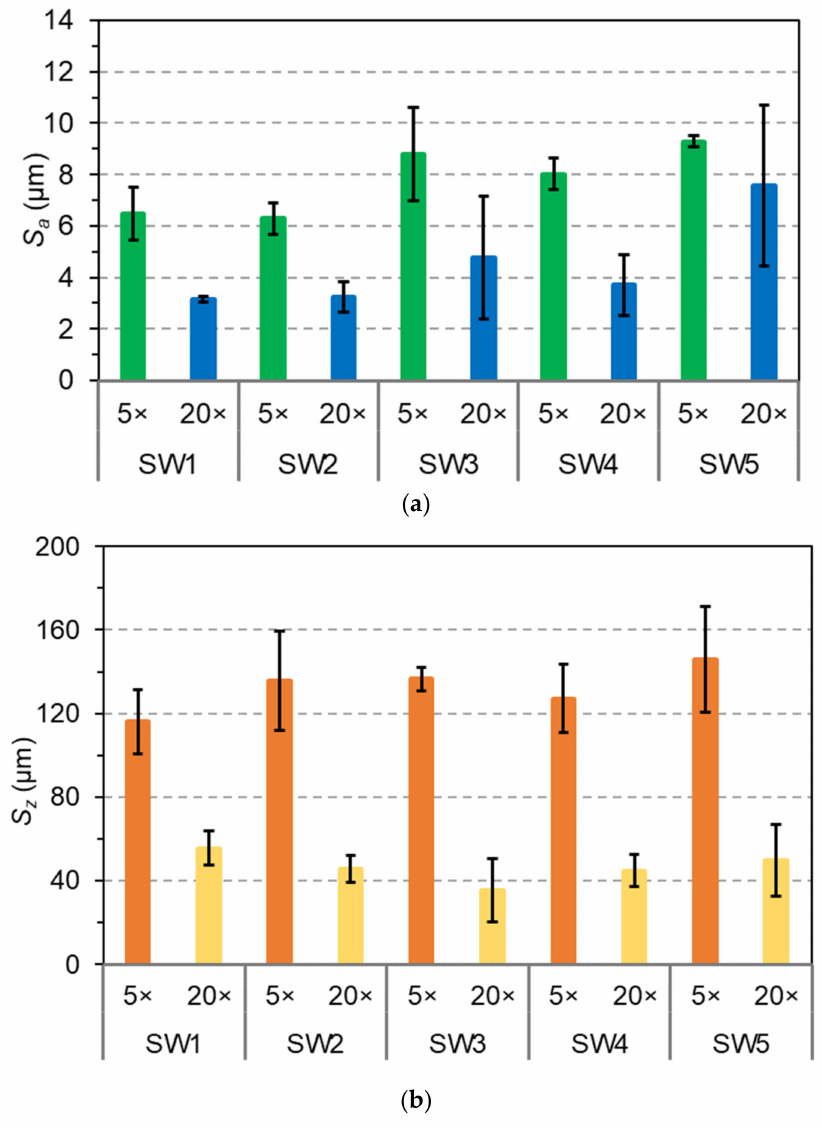
Figure 6. Surface roughness parameters of the coatings ( a ) arithmetic average S a and ( b ) maximum peak-to-valley height S z